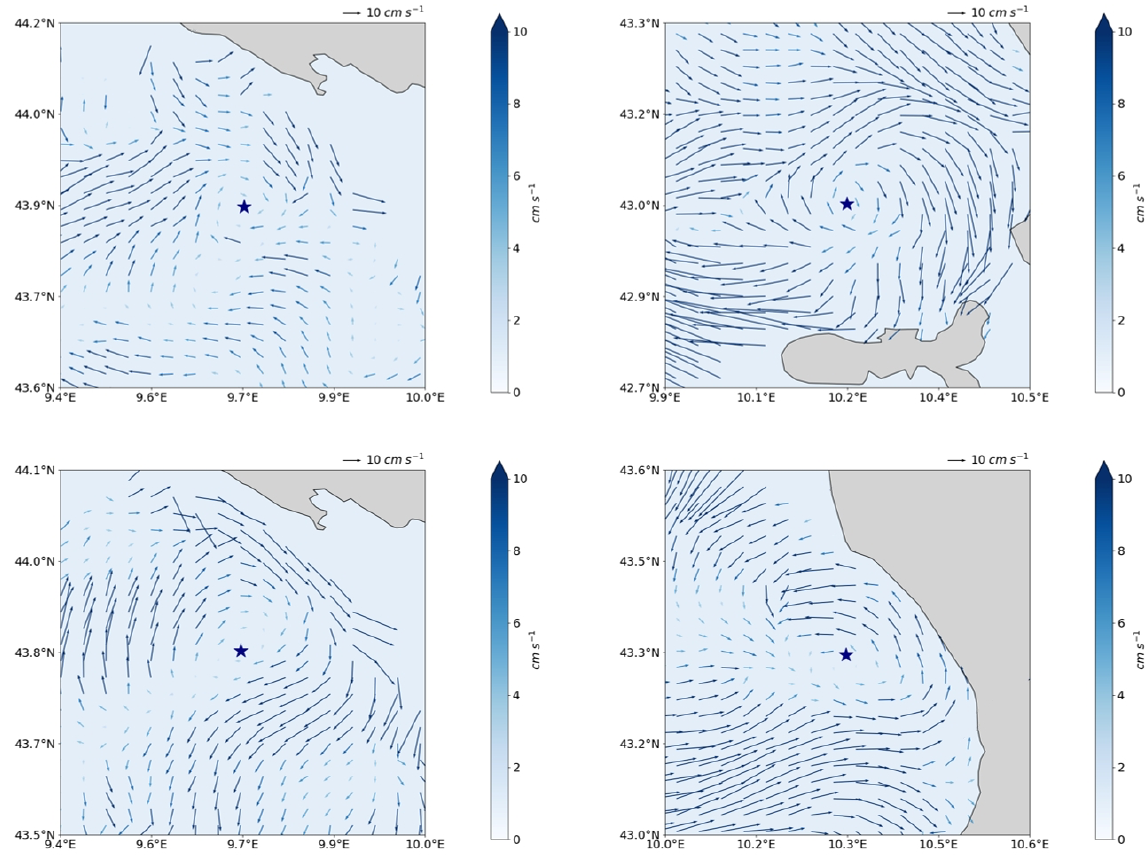
Figure 12. Maps of the area of the eastern Ligurian Sea and Tuscany Archipelago showing the HFR-derived surface currents (colored arrows indicate the current speed) and the detection of four eddies in early August 2019 by YADA. The blue star marks the eddy center.